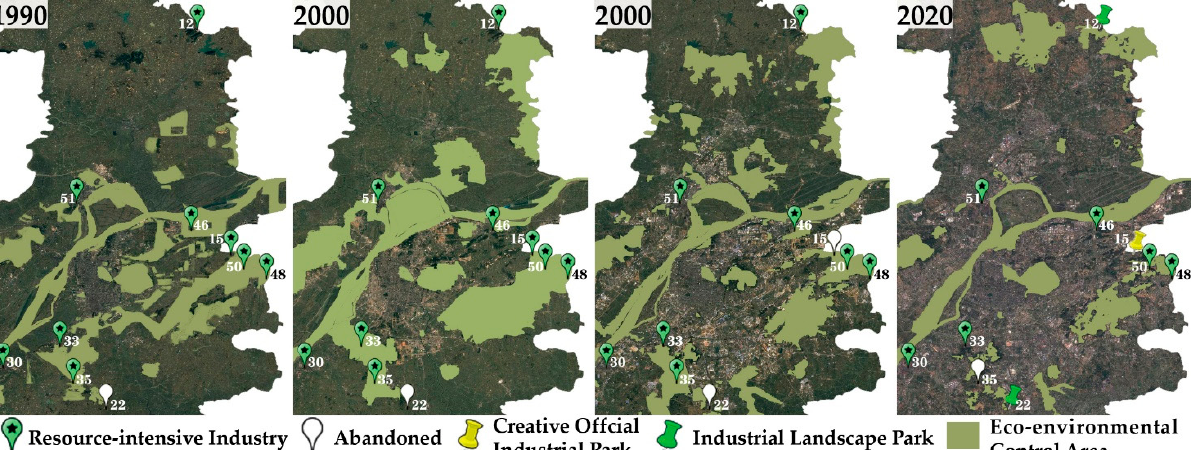
Figure 27. The change in the relationship between the operation state of resource-intensive indus- tries and the eco-environmental control area over time (Figure source: own drawing; data source: on-site investigation and interview).